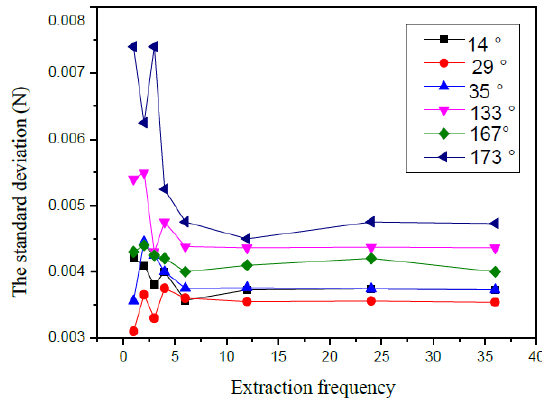
Figure 4. The standard deviation of the surface of the FAP at dif- ferent extraction